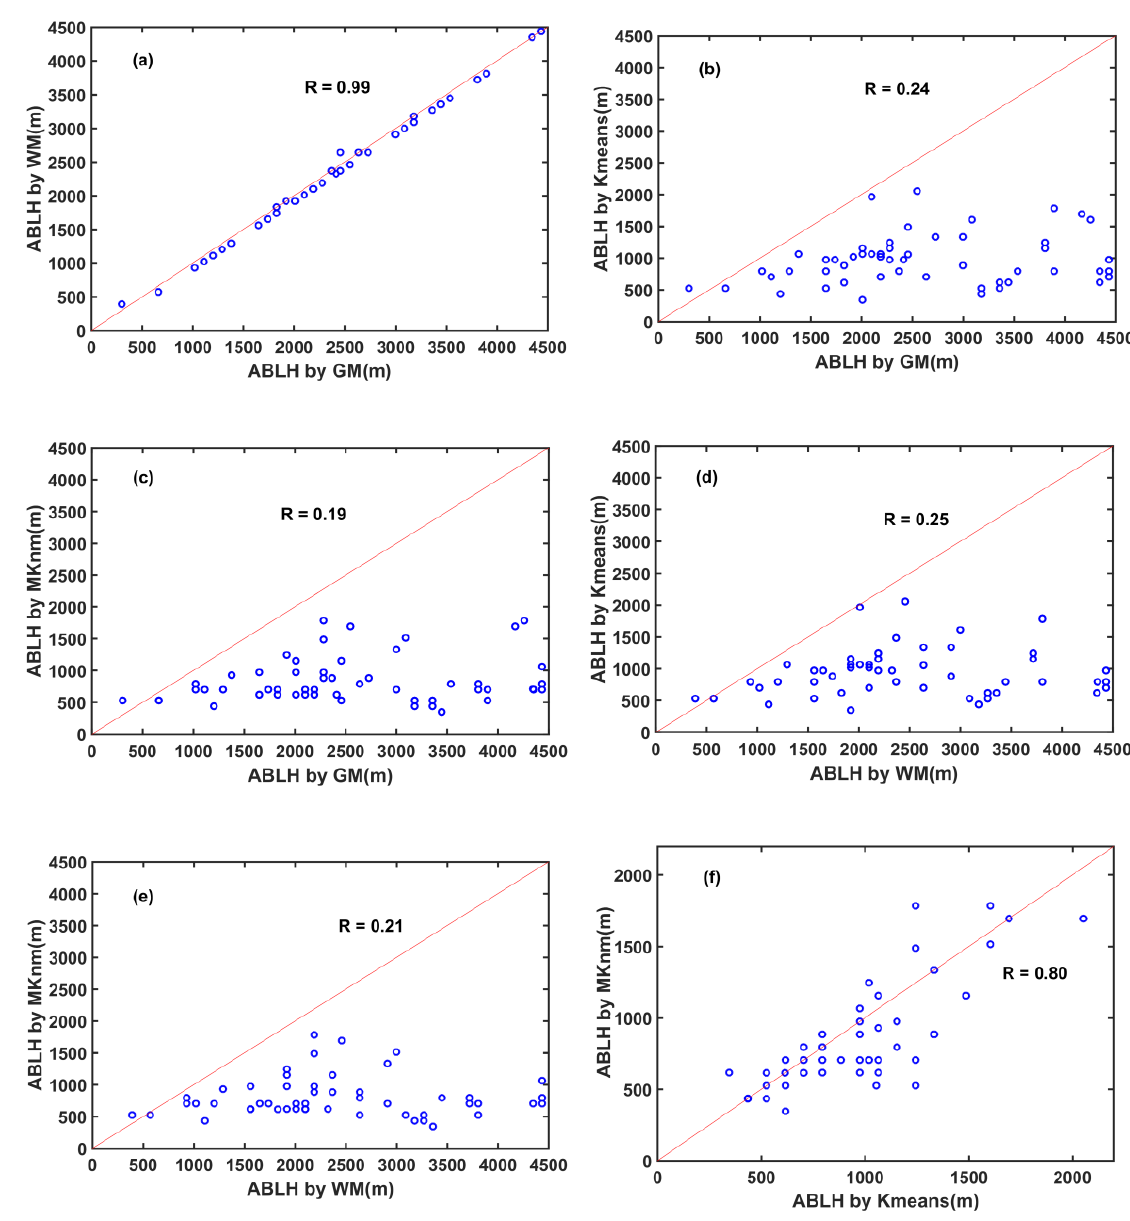
Figure 9. Intercomparison of the ABLH determined by LiDAR-based methods for 56 cases in cloud or RL conditions. ( a ) WM and GM; ( b ) Kmeans and GM; ( c ) MKnm and GM; ( d ) Kmeans and WM; ( e ) MKnm and WM; ( f ) MKnm and Kmeans. The red dotted line is the expected 1:1 reference line. Table 2. Correlation coefficients (R) of ABLH determined by LiDAR-based methods.